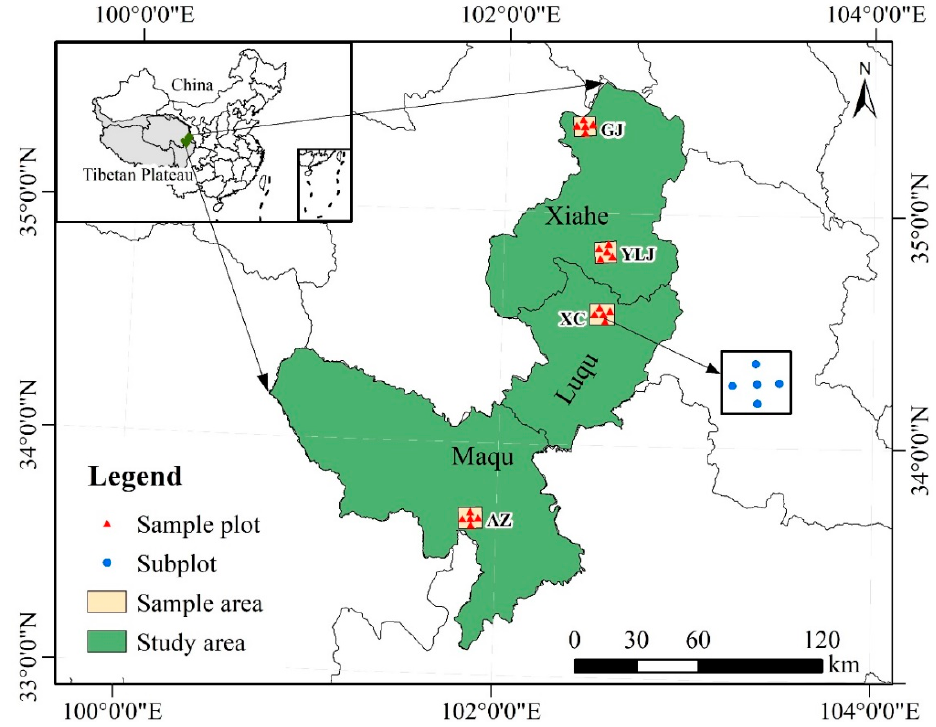
Figure 1. Study area at the northeastern margin of the Tibetan Plateau, with the four sampling areas (GJ, YLJ, XC, and AZ) from north to